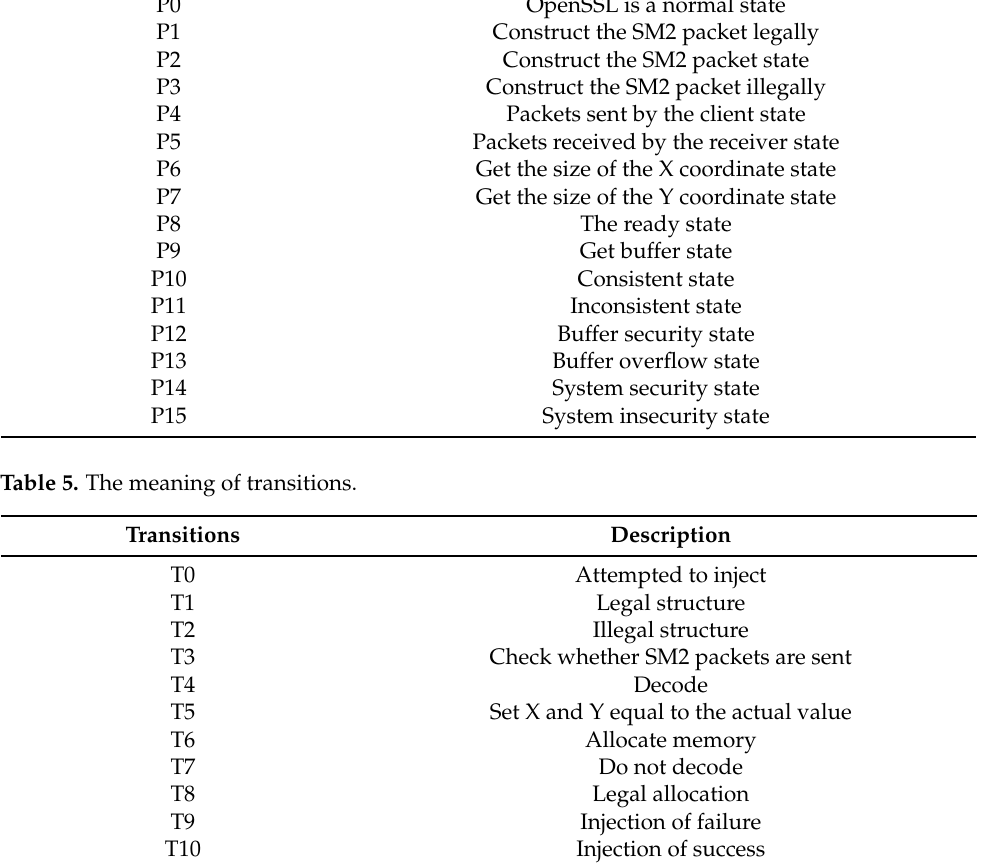
Figure 3. Petri net model with the patch. Table 4. The meaning of places.